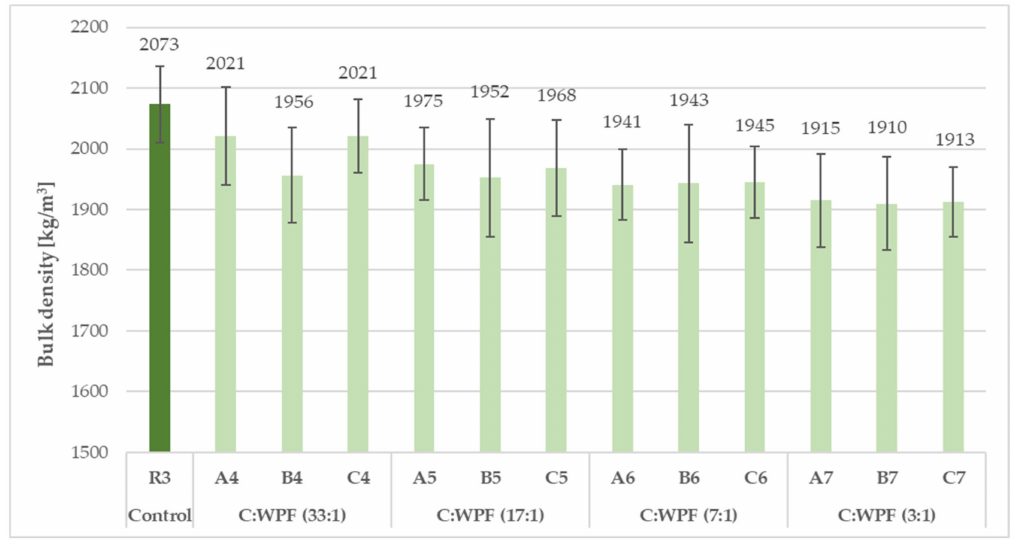
Figure 8. Development of bulk density with C/WPF ratios in fiber-cement mortars (set II) after 28 days of